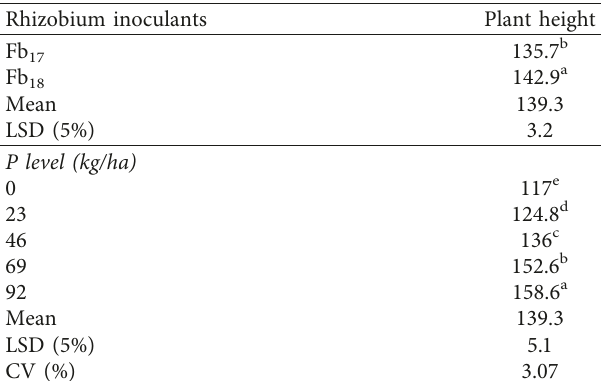
Table 11: Interaction effects of rhizobium inoculation and P fertilizer rate on number of nodule per plants.